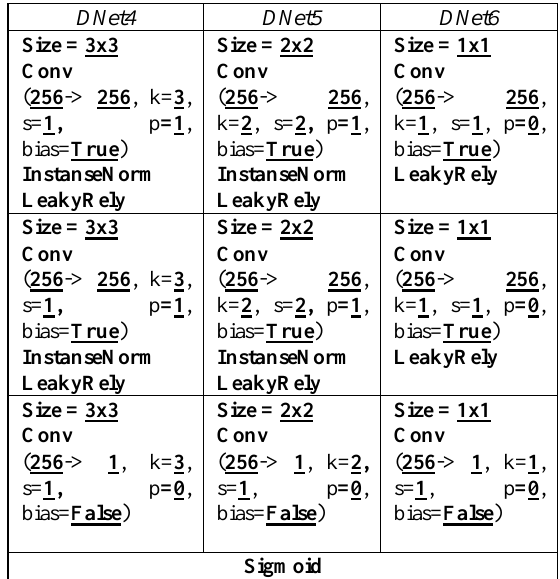
Table 1. AP gain for different object sizes.